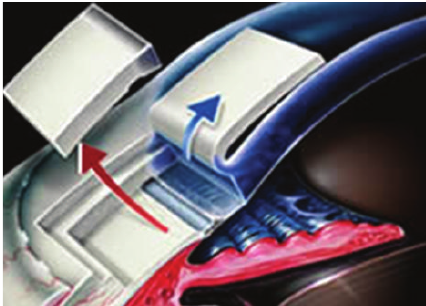
Figure 4: Schematic drawing demonstrating techniques of deep